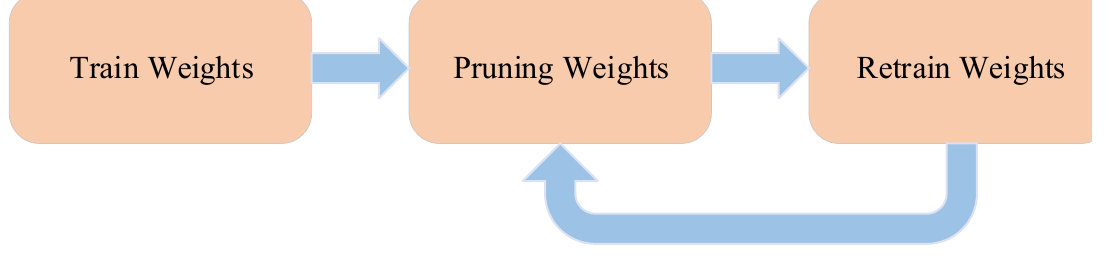
Figure 3. Three-step pruning pipeline.